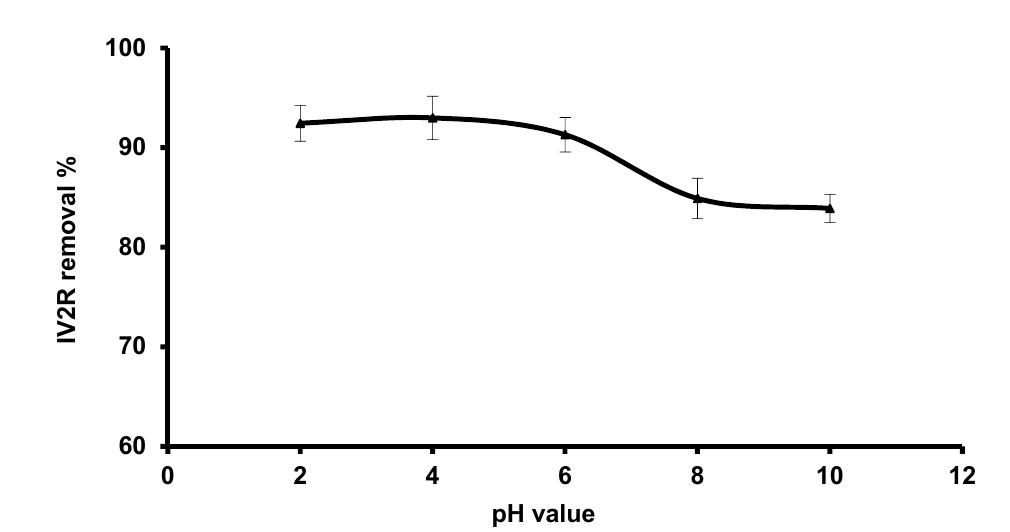
Figure 6. Influence of the pH value on the sorption of IV2R dye.